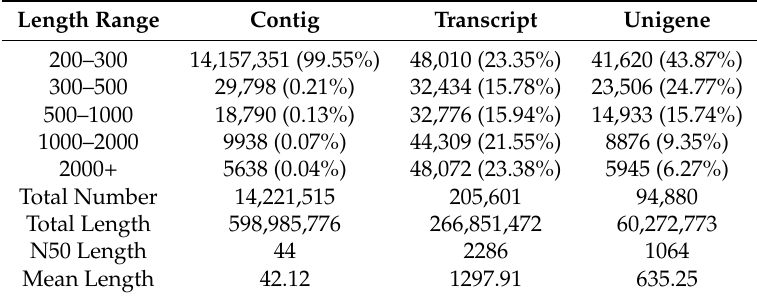
Table 1. Summary of the sequence assembly.